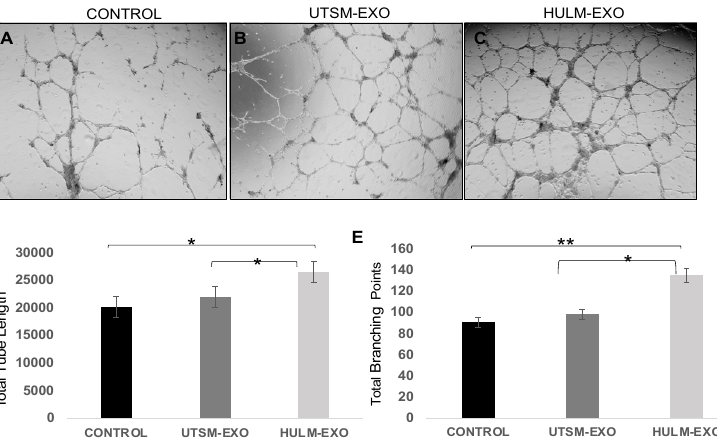
Figure 4. Exosomes from human uterine leiomyoma demonstrate angiogenic properties. ( A – C ) HEMEC cells were plated on Matrigel basement membrane matrix and treated with 30 ug/mL of HULM-EXO, UTSM-EXO, or PBS to check for changes in angiogenic properties. ( D ) HEMEC cells treated with HULM-EXO demonstrated greater tube formation and higher total tube length compared with those treated with UTSM-EXO or PBS as negative control (* p < 0.05). ( E ) Significant increase in total branching points was observed on HEMEC cells treated with HULM-EXO compared with those treated with UTSM-EXO and PBS (* p < 0.05). Values were statistically significant when p was < 0.05. (** p < 0.01).